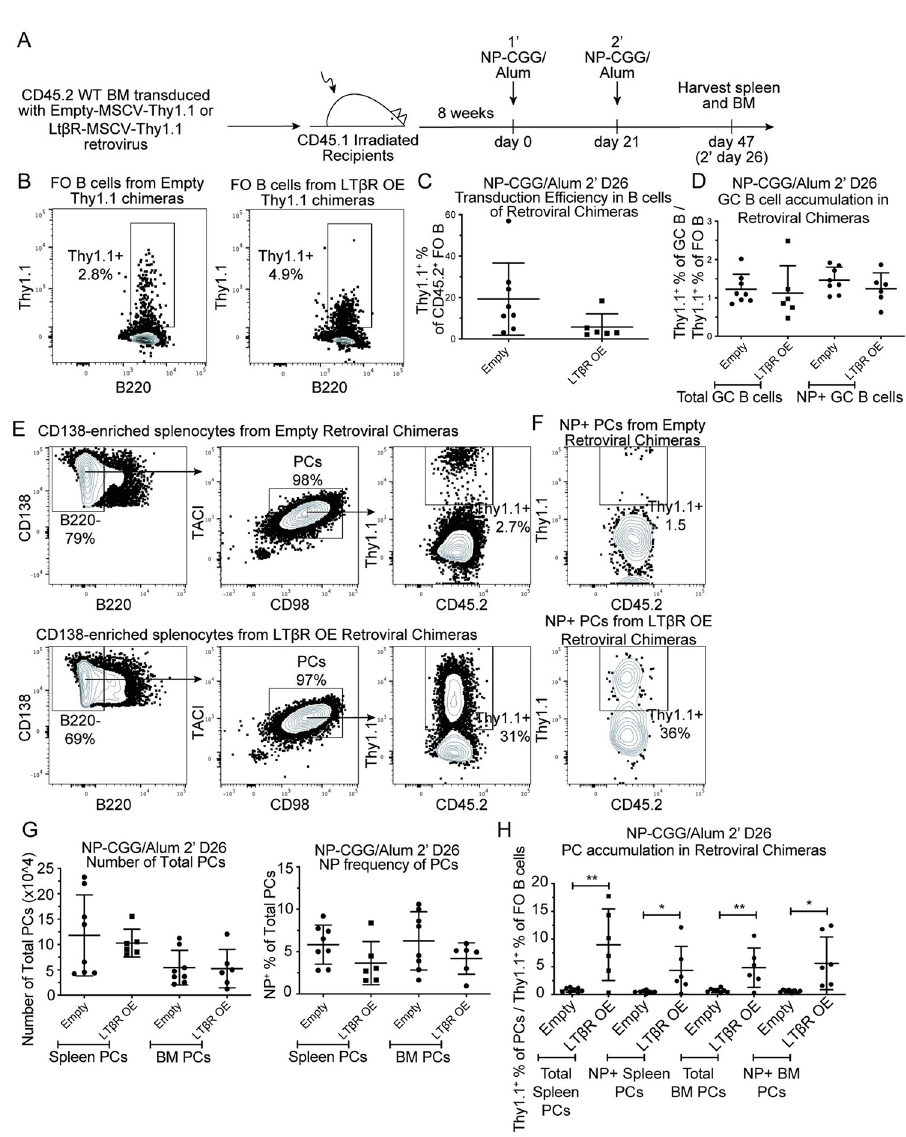
Fig 5. LT β R OE promotes PC accumulation in vivo. (A) Diagram of experimental scheme. Chimeras were made by retroviral transduction of CD45.2 + WT BM with Empty-MSCV-Thy1.1 or LT β R-MSCV-Thy1.1 (LT β R OE) retrovirus and transfer into irradiated CD45.1 + recipients. After reconstitution, mice were immunized with NP-CGG/Alum two times 21 days apart. After 26 days from the booster immunization, spleen and BM were analyzed. (B) Representative flow plots representing Dump - B220 + CD45.2 + CD45.1 - IgD + spleen FO B cells with gates on Thy1.1 + cells. (C) Thy1.1 frequency of FO B cells. (D) Thy1.1 frequency of spleen GC B cells normalized to Thy1.1 frequency of FO B cells in matched mice. (E) FACS plots of Dump - CD138 + CD45.2 + cells with gates on B220 - , TACI + CD98 + PCs with further gates on Thy1.1 cells among total spleen PCs or (F) NP + spleen PCs. NP + PCs were identified as NP16-PE + and decoy SA-PE-AF647 - . (G) Number of total spleen or BM PCs (left) and NP frequency of PCs (right). (H) Thy1.1 frequency of spleen or BM PCs normalized to Thy1.1 frequency of FO B cells in matched mice. Data shown in all panels are representative of two independent experiments (n = 6–8 mice per group). � p < 0.05, �� p <